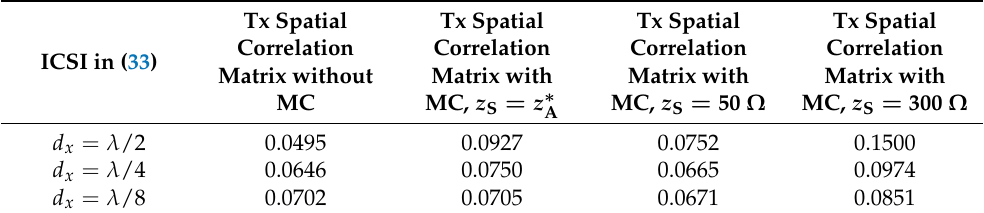
Table 1. Inter-element correlation/coupling strength indicator (ICSI) in (33) for Tx spatial correlation matrix without and with MC under various element spacing.